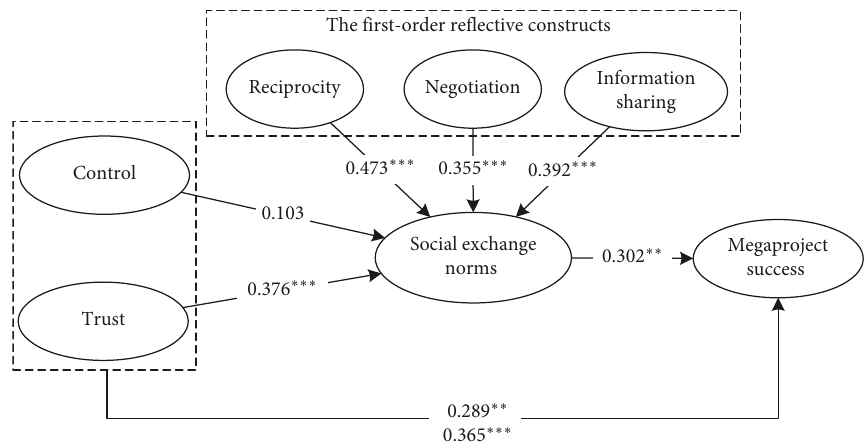
Figure 2: Results of structural equation modeling.